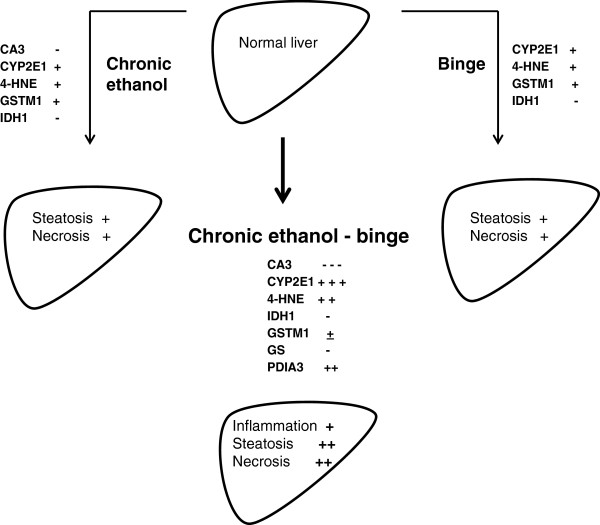
A flow diagram showing proteome changes and their relationshsip to liver injury by chronic ethanol binge in the rat model. This schematic figure depicts that binge, and chronic ethanol have their own effects, but chronic ethanol exposure renders liver more susceptible to amplification of injury by binge ethanol. The figure shows changes in the levels of CA3, CYP2E1, 4HNE, PDIA3 and other components after different treatments. Minus (−) and plus (+) symbols indicate the degree of decrease or increase, respectively.